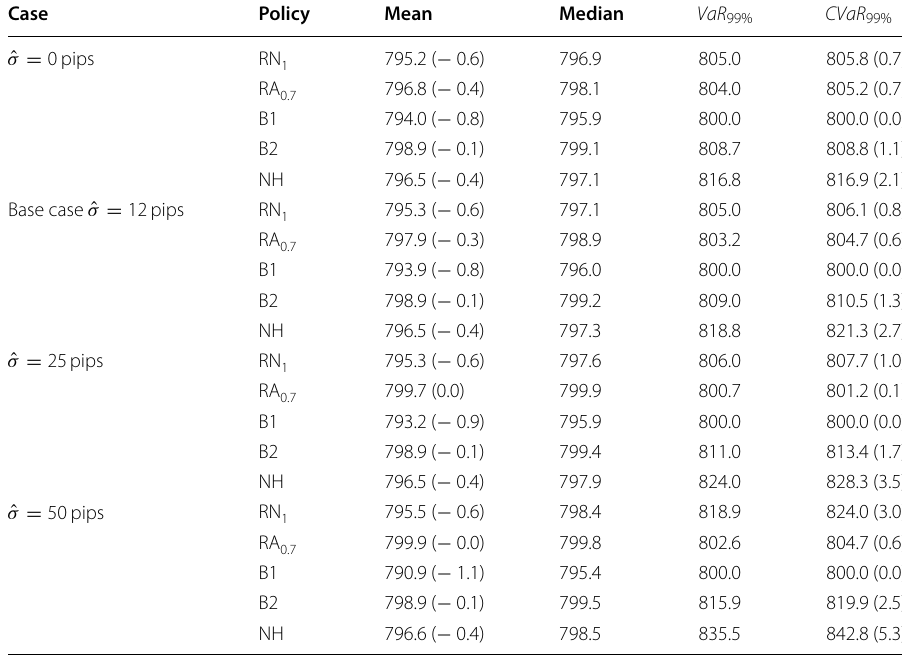
σ in the GBM intraday price process for the USDCLP. The rest of the ˆ ( 1.25%,3.75% =